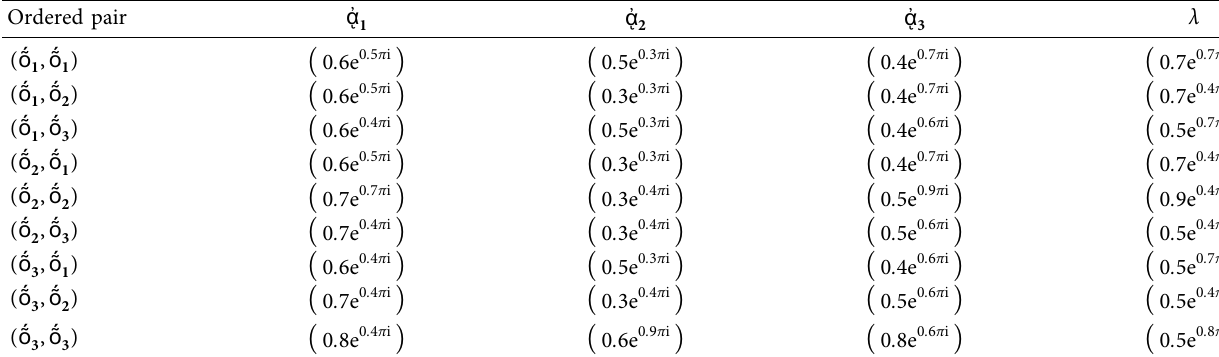
Table 5: Cartesian product.